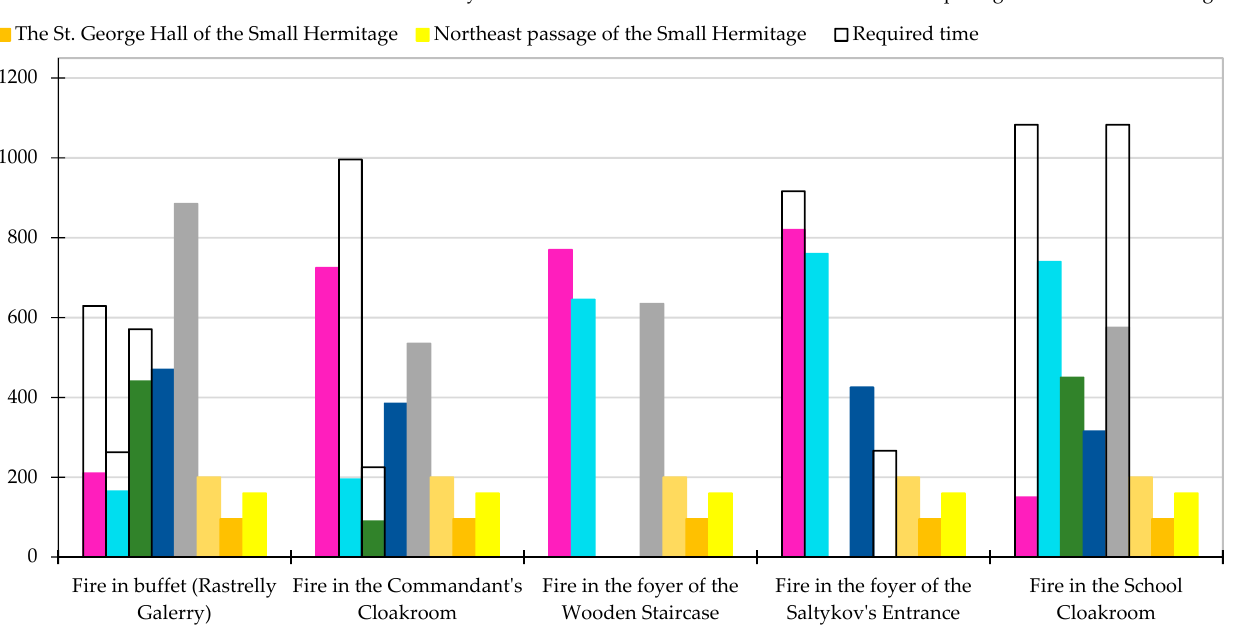
Figure 21. Evacuation time by stairs.